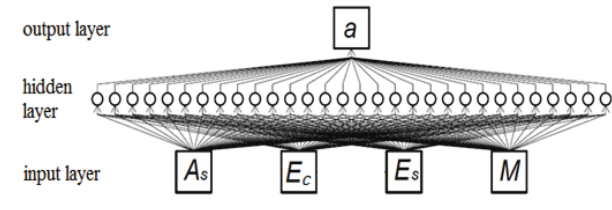
Table 2. Parameters of the